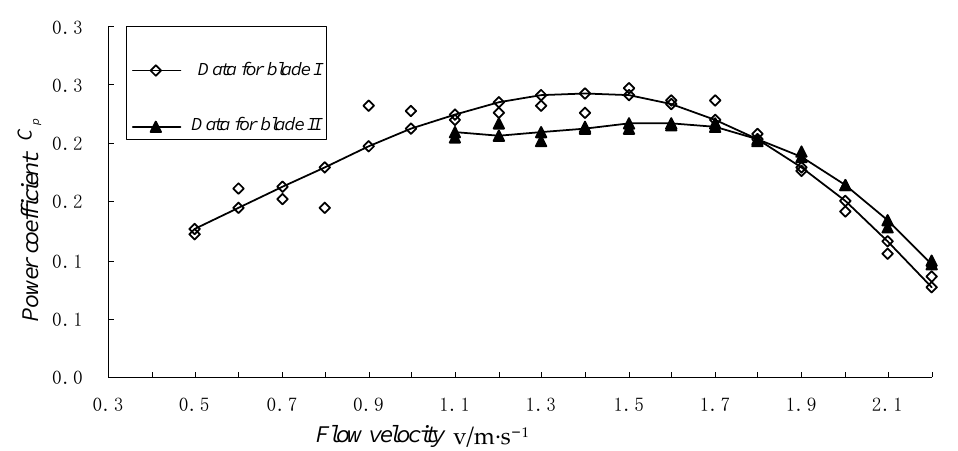
Figure 17. Power coefficient of the blade at different velocities.